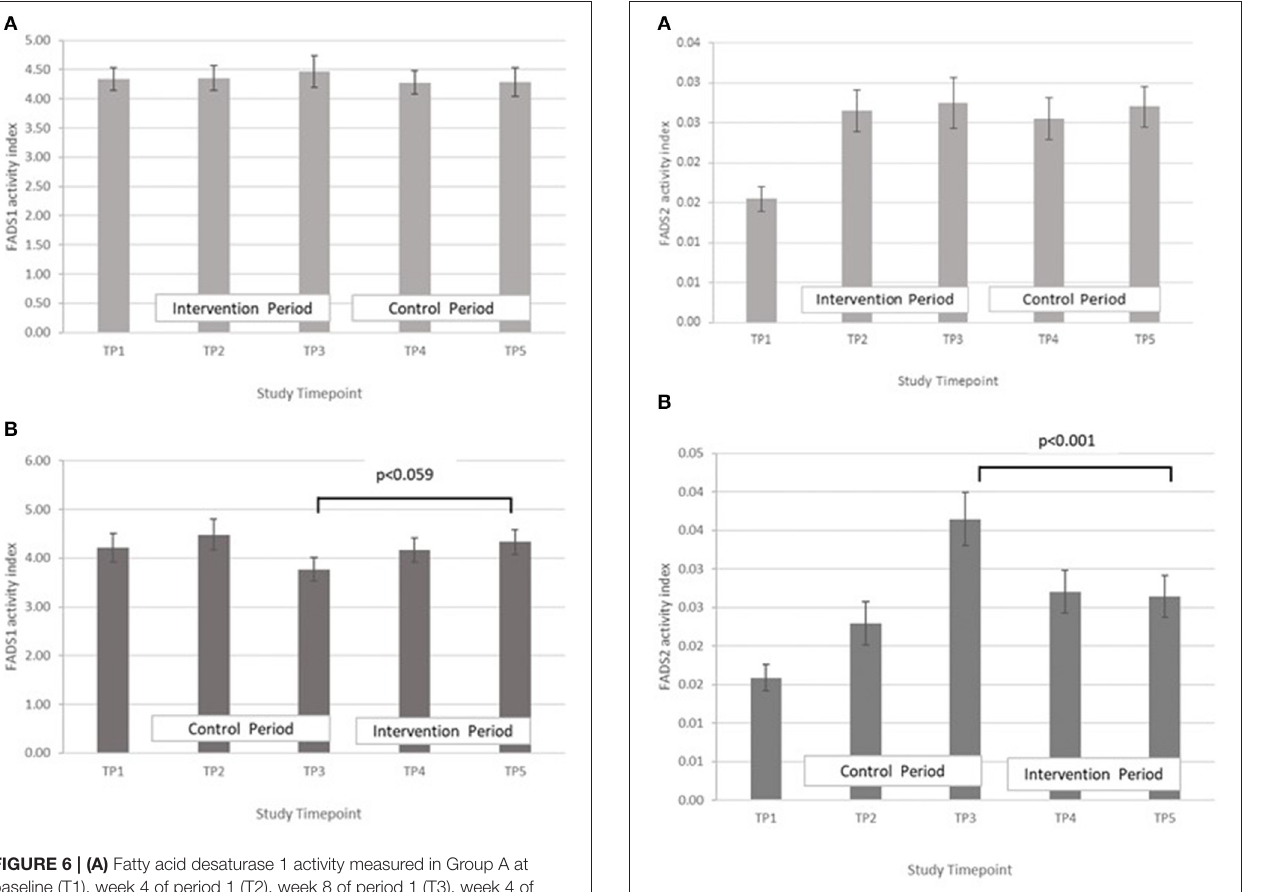
FIGURE 7 | (A) Fatty acid desaturase 2 activity measured in Group A at baseline (T1), week 4 of period 1 (T2), week 8 of period 1 (T3), week 4 of period 2 (T4) and week 8 of period 2 (T5). Bars indicate estimated marginal means with standard error. (B) Fatty acid desaturase 2 and elongase-5 activity measured in Group B at baseline (T1), week 4 of period 1 (T2), week 8 of period 1 (T3), week 4 of period 2 (T4) and week 8 of period 2 (T5). Bars indicate estimated marginal means with standard